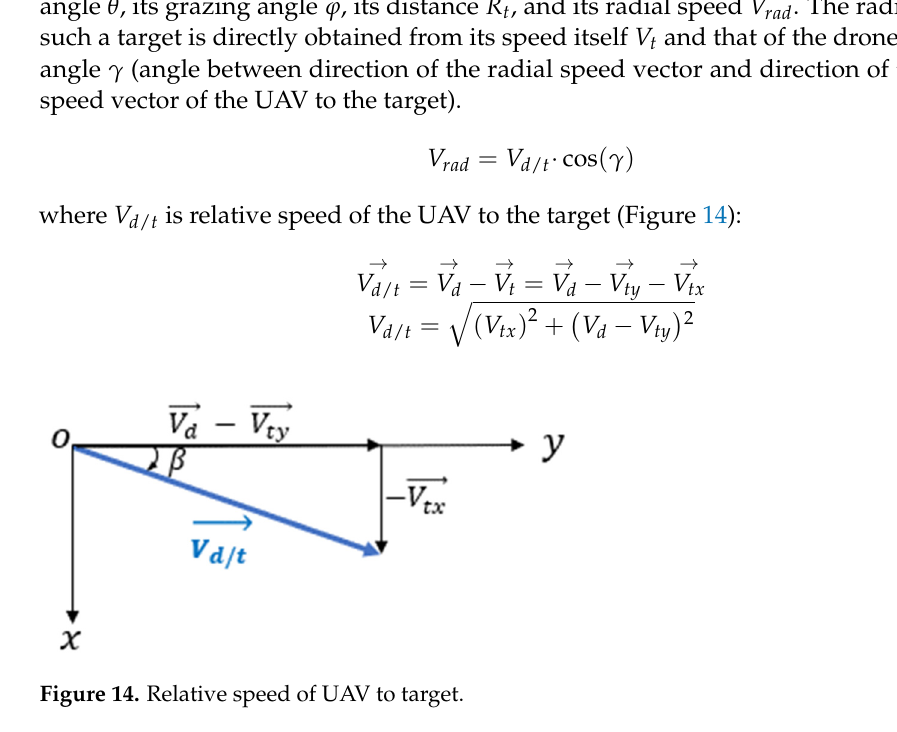
(41) Positive relative radial velocity indicates that the radar platform is approaching the target. Negative relative radial speed indicates that the radar platform is moving away from the target.